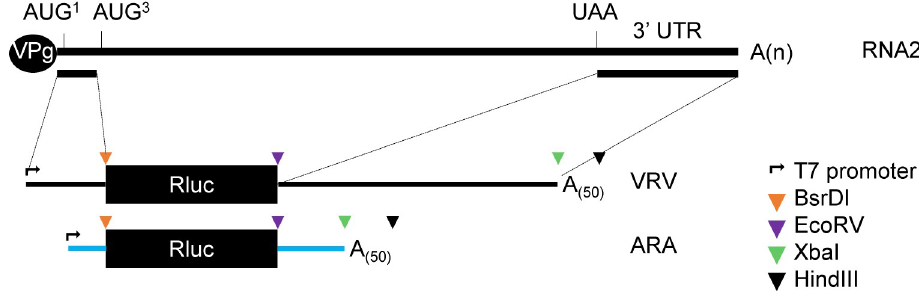
Fig 1. Schematic representation of reporter constructs. All constructs include the Rluc (Renilla luciferase) reporter gene and a T7 promoter site upstream of the 5’ UTR for in vitro transcription. The ToRSV-Rasp1 RNA2 is shown at the top along with the AUG 1 and AUG 3 putative start codons and the UAA stop codon. The VRV reporter transcript consists of the Rluc ORF (black box) flanked by the 5’ region (first 443 nts) and complete 3’ UTR of ToRSV-Rasp1 RNA2 (black lines). The control ARA transcript, includes the 5’ and 3’ UTRs from the Arabidopsis thaliana actin gene (blue lines). A 50 nts stretch of polyA sequence followed by a HindIII restriction site was added at the 3’ end of all constructs. Additional restriction sites that facilitate cloning of derivative constructs are shown by coloured